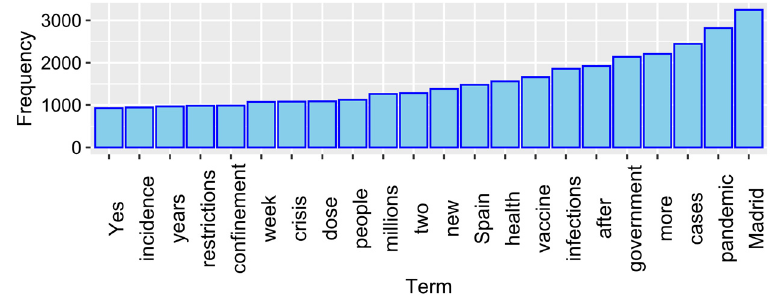
Figure 3. Terms with a higher frequency of matrix DTM.